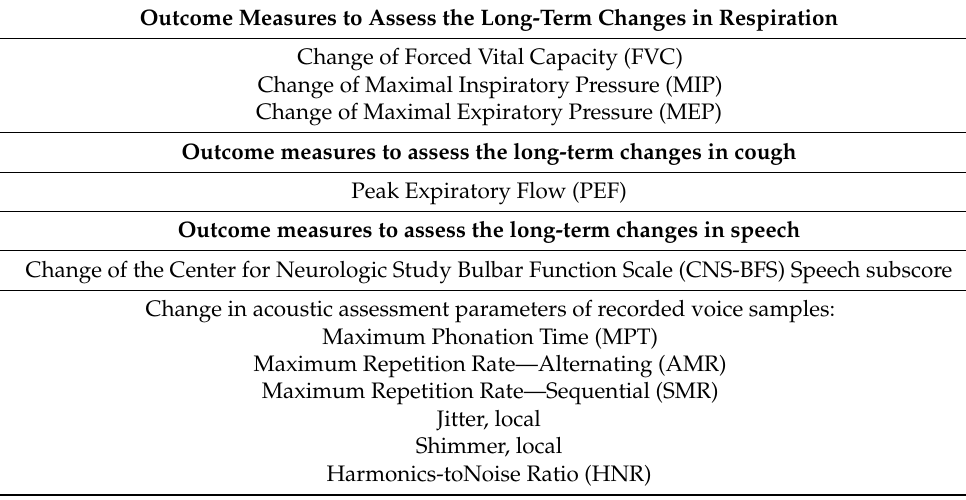
Table 32. Suggested biomedical outcome measures and parameters for the efficacy